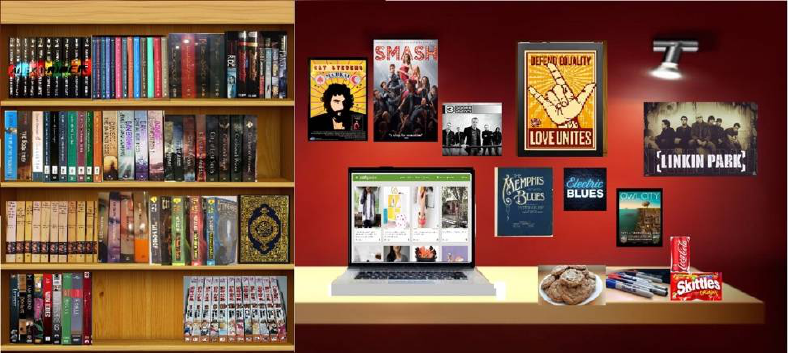
Figure 4. Student project, A Media Rich Environment .